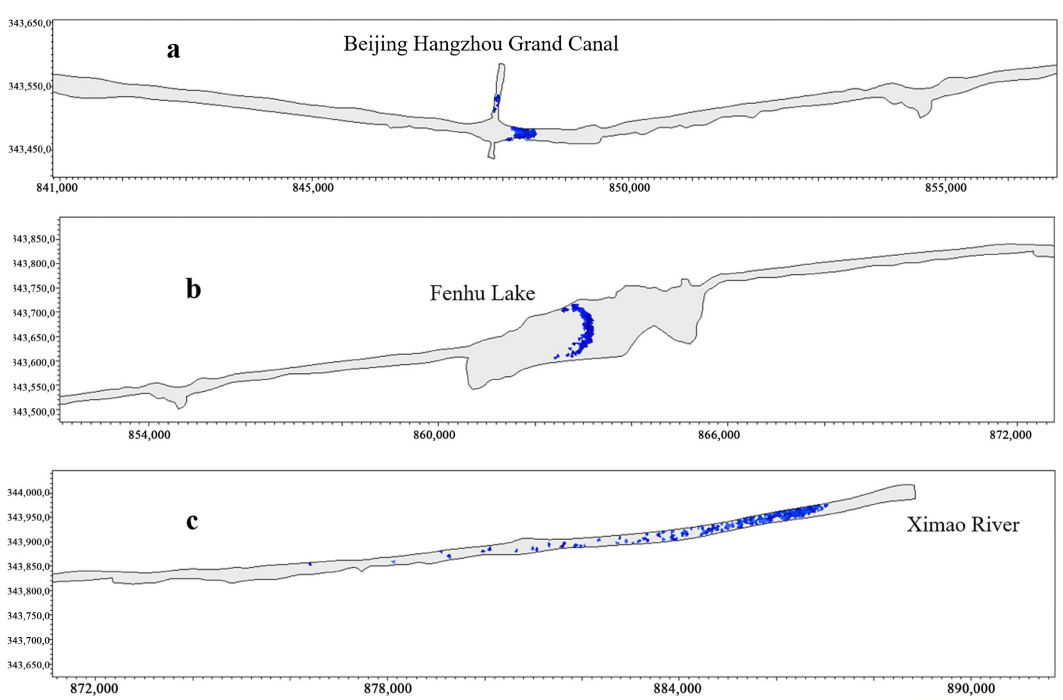
Figure 6. Simulation results of an oil spill accident in Taipu River (The blue dots represent the oil film distribution. ( a ). Section of Beijing Hangzhou Grand Canal; ( b ). section of Fenhu Lake; ( c ). section of Ximao